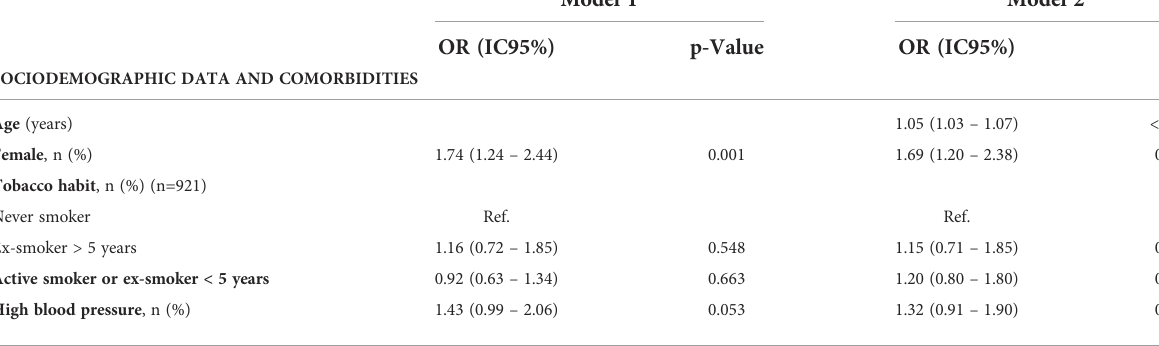
TABLE 5 Multivariate analysis to assess factors related to worse prognosis (Rankin 0-3 vs. Rankin 3-6) in patients between 40 and 79 years old with a fi rst acute ischemic stroke